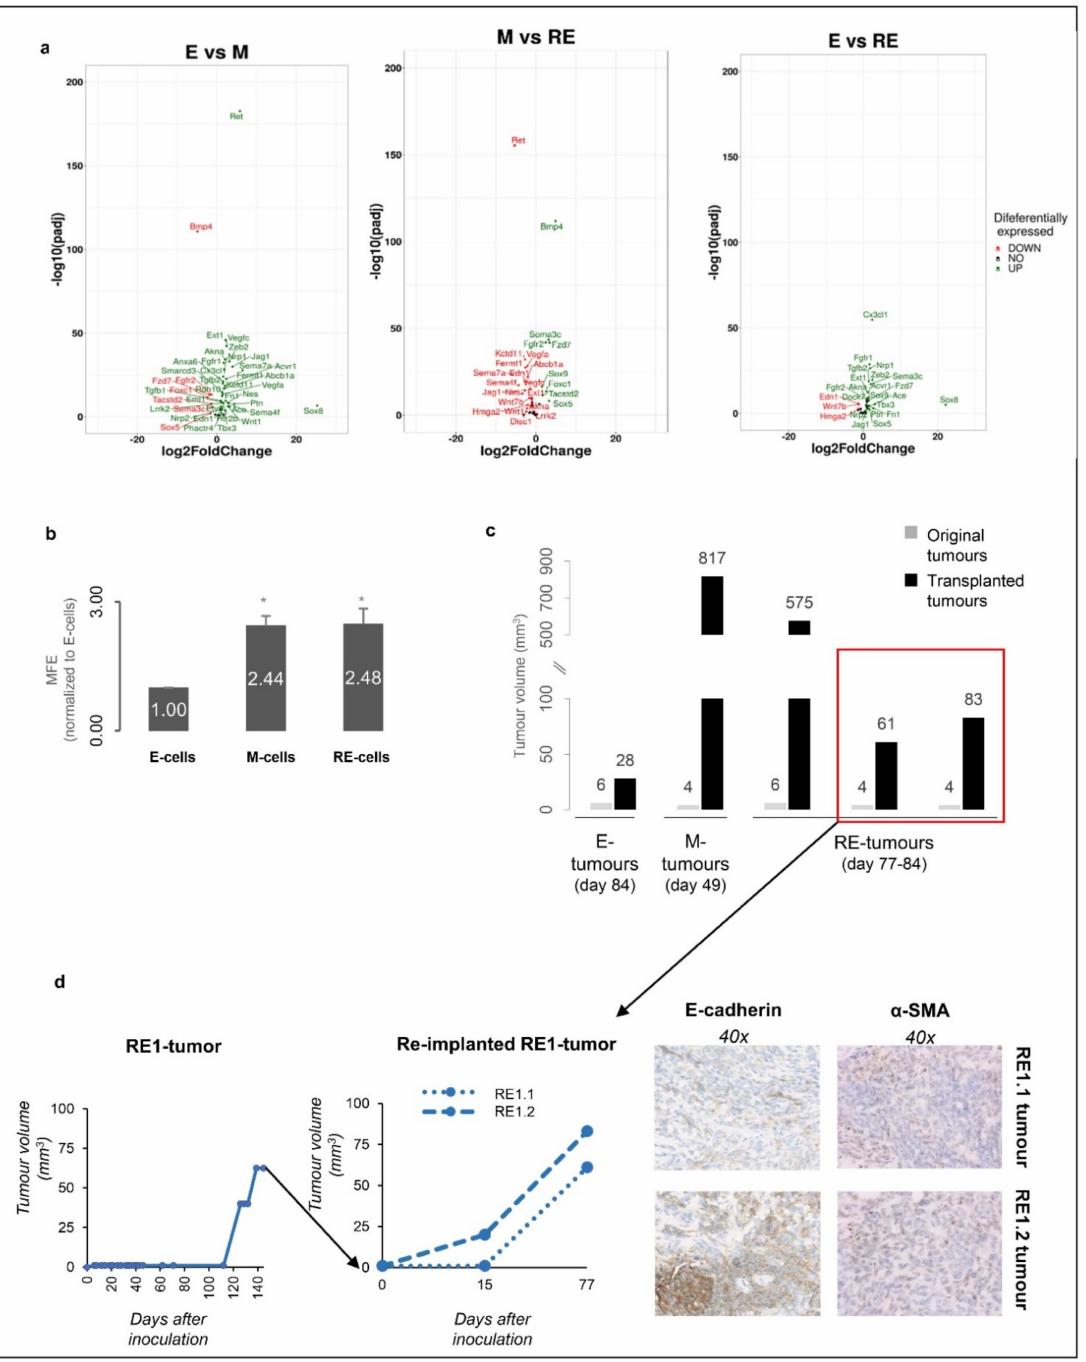
Figure 5. RE cells displayed increased stemness potential. ( a ) Volcano plots of stemness-related DEGs. ( b ) E, M and RE cells’ first-passage mammosphere formation efficiencies (* for p < 5.00 × 10 − 2 ). ( c ) Pilot in vivo syngeneic transplantation assay for E, M and RE tumours. Comparison shown between the final tumour volumes for the original E, M and RE tumours used (grey bars) and the corresponding tumours obtained after syngeneic transplantation (black bars) at the same time point post-inoculation or transplantation. ( d ) (left panel) Growth curve of an RE tumour in the first passage in mice (left) and after reinoculation of two tumour pieces (right). (right panel) E-cadherin and α -SMA immunohistochemistry staining of representative RE reimplanted